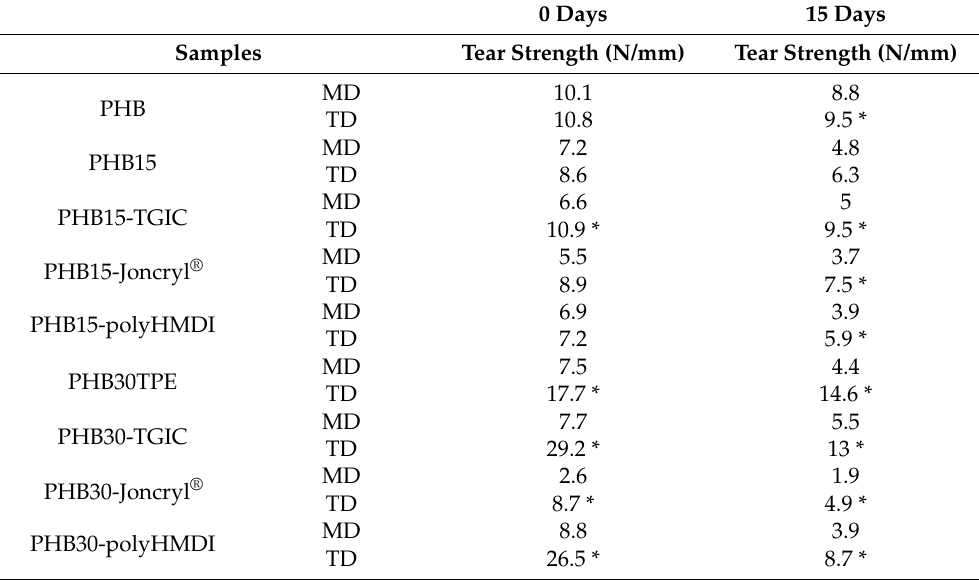
Table 3. Tear strength parameters obtained for the blends at 0 and at 15 days of